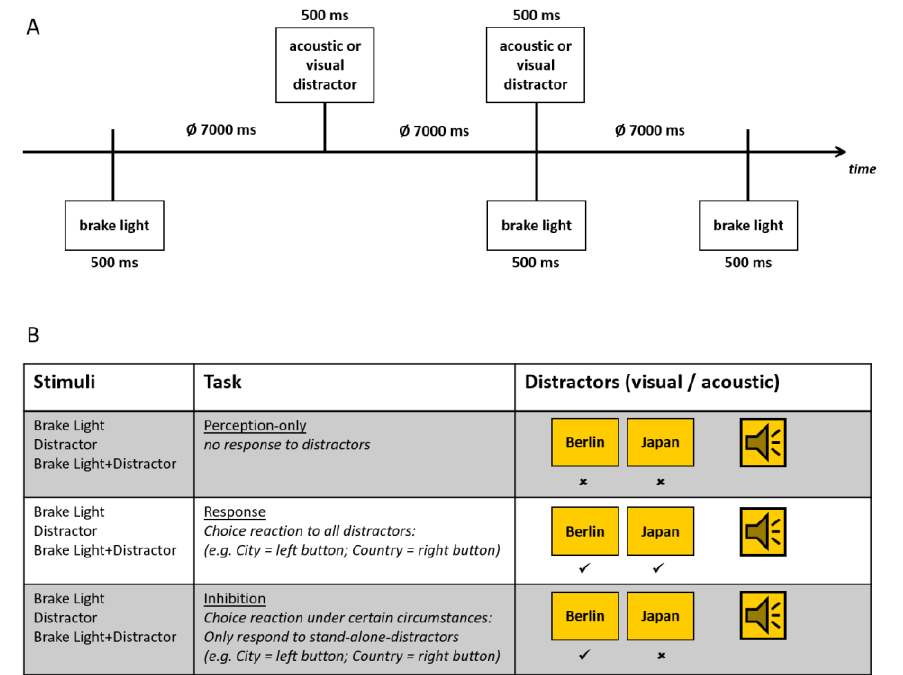
Figure 2. ( A ) Schematic representation of the time sequence of the brake light and secondary stimuli during driving simulation ( B ) overview of the three different tasks with their instructions and the required (non-)reaction to the visual/acoustic distraction stimuli.